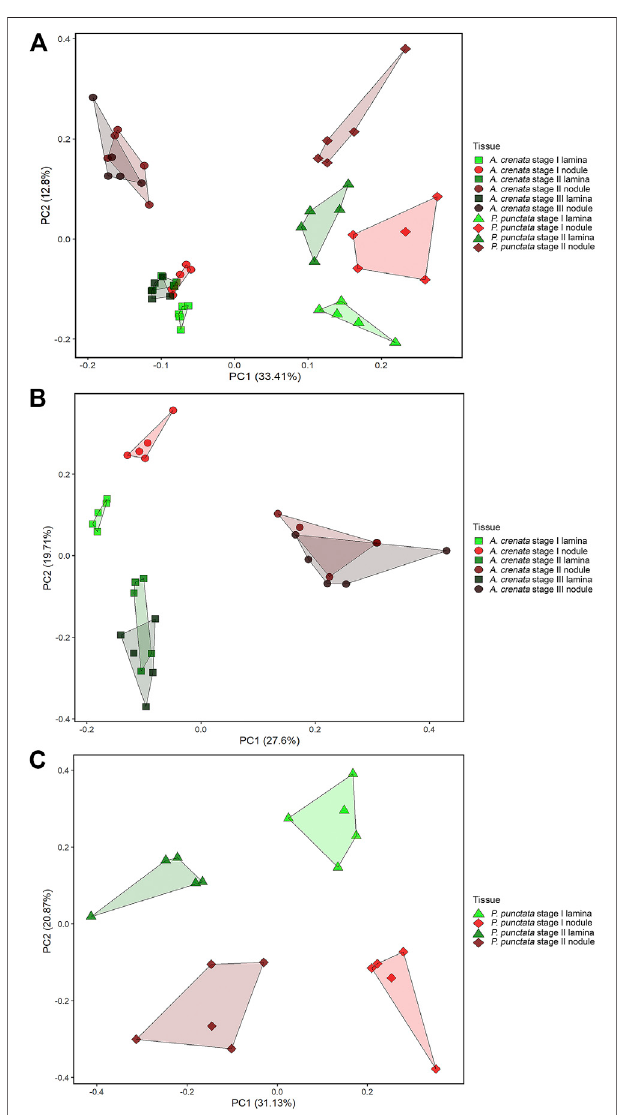
FIGURE 3 | (A) PCA analysis of 338 centered and scaled m/z features from LC-MS and GC-MS analysis of Ardisia crenata and Psychotria punctata lamina tissue and nodule extracts. (B) PCA analysis of 276 centered and scaled m/z features from LC-MS and GC-MS analysis of Ardisia crenata lamina tissue and nodule extracts. (C) PCA analysis of 255 centered and scaled m/z features from LC-MS and GC-MS analysis of Psychotria punctata lamina tissue and nodule